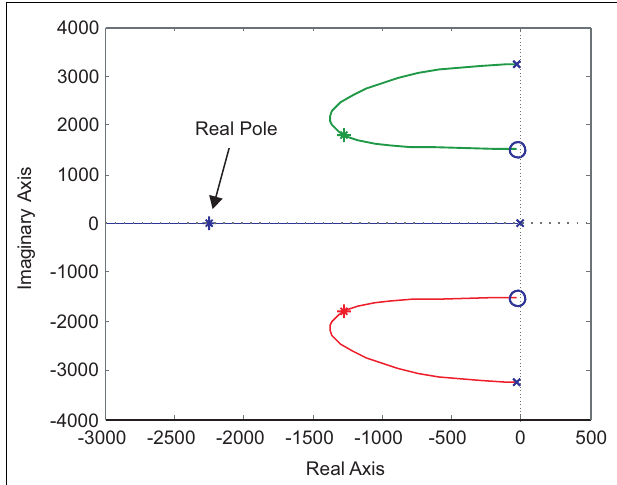
FIGURE 4 | The root-locus of the damped system G xf . The asterisks mark the optimal pole locations. Note that the closed-loop system contains an additional pole on the real axis.